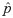
Parameter estimation from epidemiological data and derivation of the PA-regression-function.
A. In order to estimate the clinically observed fraction of PA-I, we utilize data from the literature. B. The estimated fraction of PA-I cases p^ is interpreted as absorption probability in state N in our model. Eq (3) allows to estimate the corresponding risk coefficient γ^. C. Substituting the estimated risk coefficient γ^=0.152 in Eq (5) determines the PA-regression-function β
0.152(ρ) which is plotted in purple. Furthermore, the blue plots indicate the corresponding regression functions for values of γ which are obtained within the standard deviation of p^.